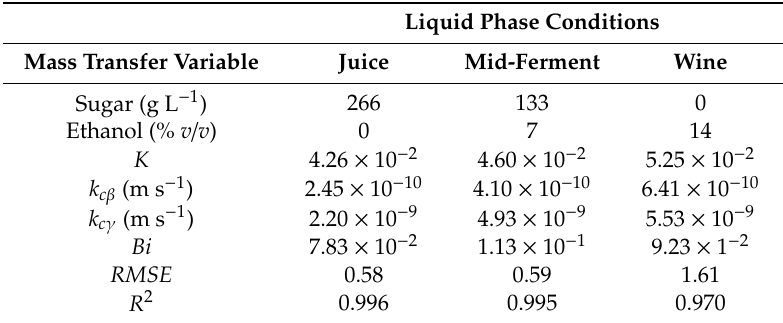
Figure 2. Experimental and fitted models under natural convection conditions for ( a ) solid phase depletion and ( b ) liquid phase accumulation of malvidin-3-glucoside. 266 g L − 1 sugar; (cid:78) , 133 g L − 1 sugar and 7% v / v ethanol; (cid:95) , 14% v / v ethanol. Error bars represent the standard deviation across three replicates. Table 2. Summary of liquid phase conditions, mass transfer properties ( D s γ , k c γ , D s β , k c β , and K ), Biot number ( Bi ), and statistical parameters ( RMSE and R 2 ) for malvidin-3-glucoside solved using the method outlined in Section 3.2 for natural convective extraction.